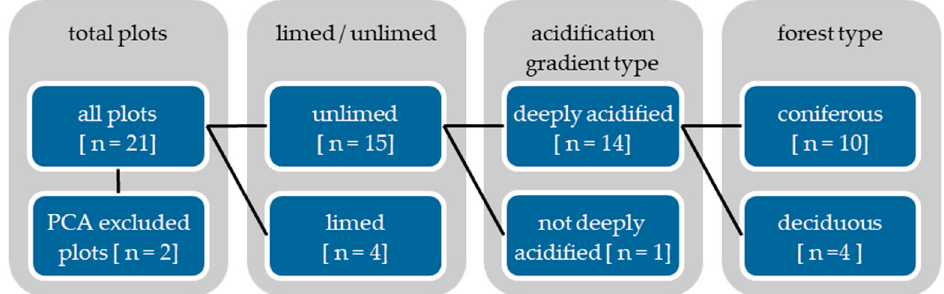
Figure 4. Stratification of the inventory plots into functional groups for detailed statistical analysis. Further details on the definition of the “vertical acidification gradient type” can be found in Hart- mann and von Wilpert [59] and in Section 3.2. PCA = principal component analysis.